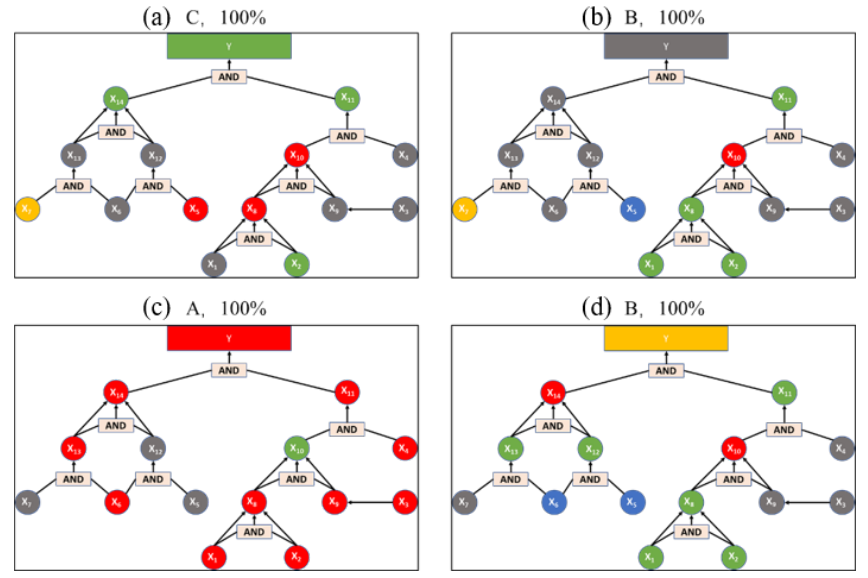
Figure 10. Partial training results of additional samples. ( a ) shows this spare part is 100% classified into class C; ( b ) and ( d ) indicate these two spare parts are 100% classified into class B; ( c ) shows this spare part is 100% classified into class A.